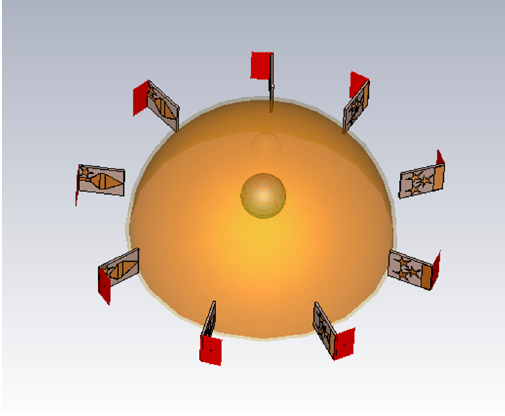
Figure 9. Proposed simulated Imaging setup with breast phantom.